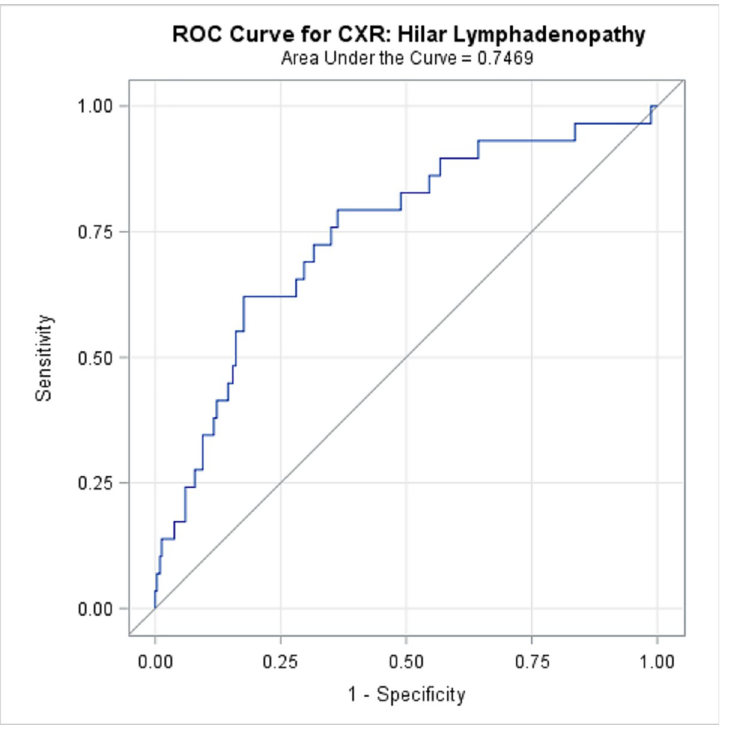
Fig 1. ROC Curve for CXR: Hilar Lymphadenopathy.